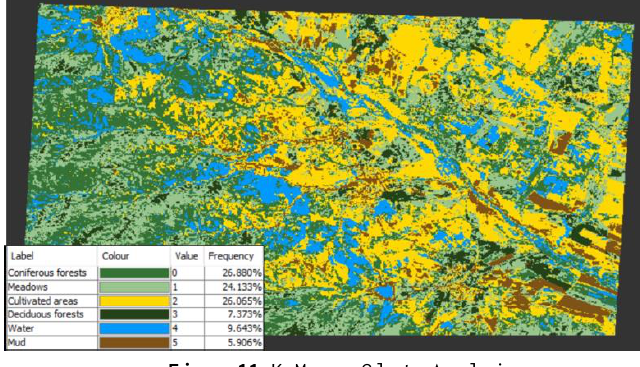
Figure 11. K-Means Cluster Analysis